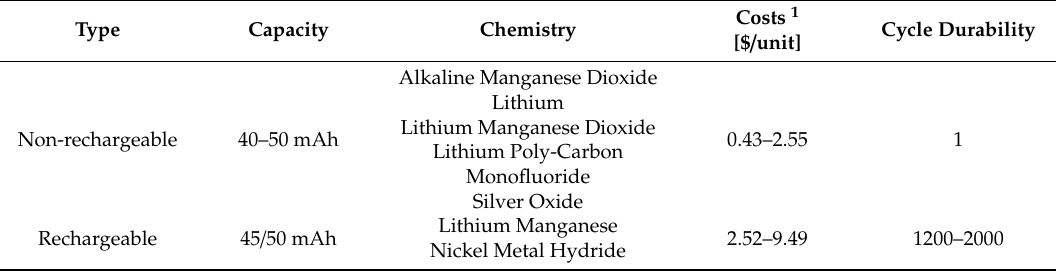
Table 5. Comparison rechargeable / non-rechargeable coin-size